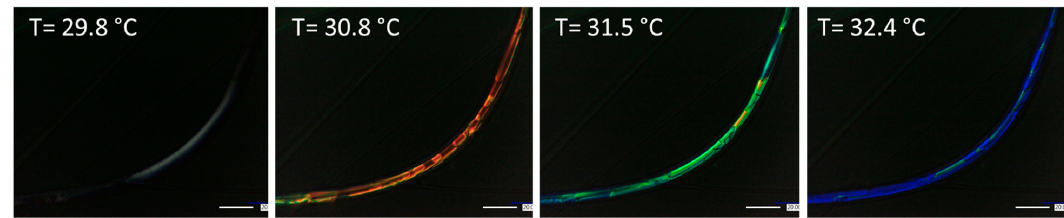
Figure 8. Polarized light microscopy of coaxially electrospun PVP shell, LC-2 core fibers heated from ambient conditions. Thermochromic behavior, i.e., a transition from red to blue, was observed upon heating. The temperatures indicated are the stage temperature.